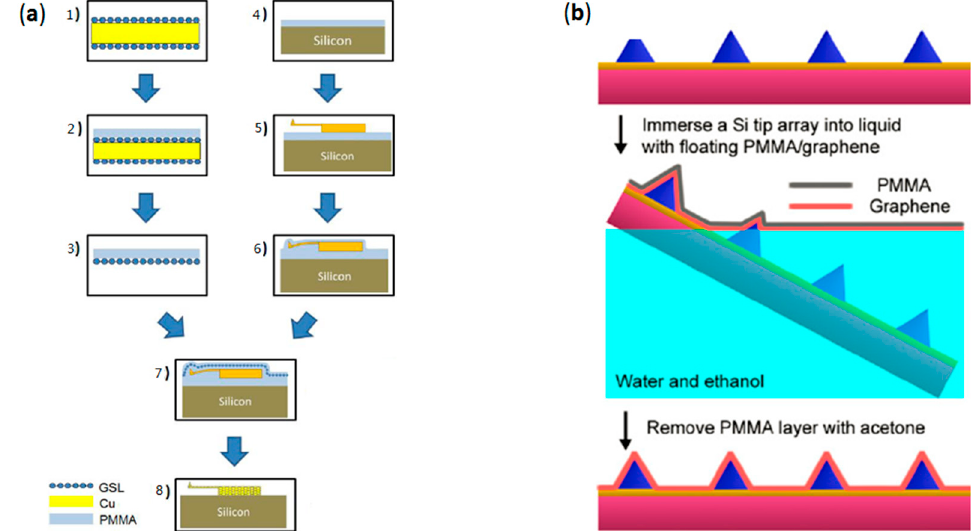
Figure 2. Transfer of CVD-grown graphene onto AFM probe tips. ( a ) Step-by-step schematic of the process followed to transfer graphene (grown on Cu foils) onto AFM tips. Reproduced with permission from [24], copyright Wiley-VCH (2013): ( b ) Experimental protocol used to fabricate graphene coated tip arrays. Reproduced with permission from [25], copyright